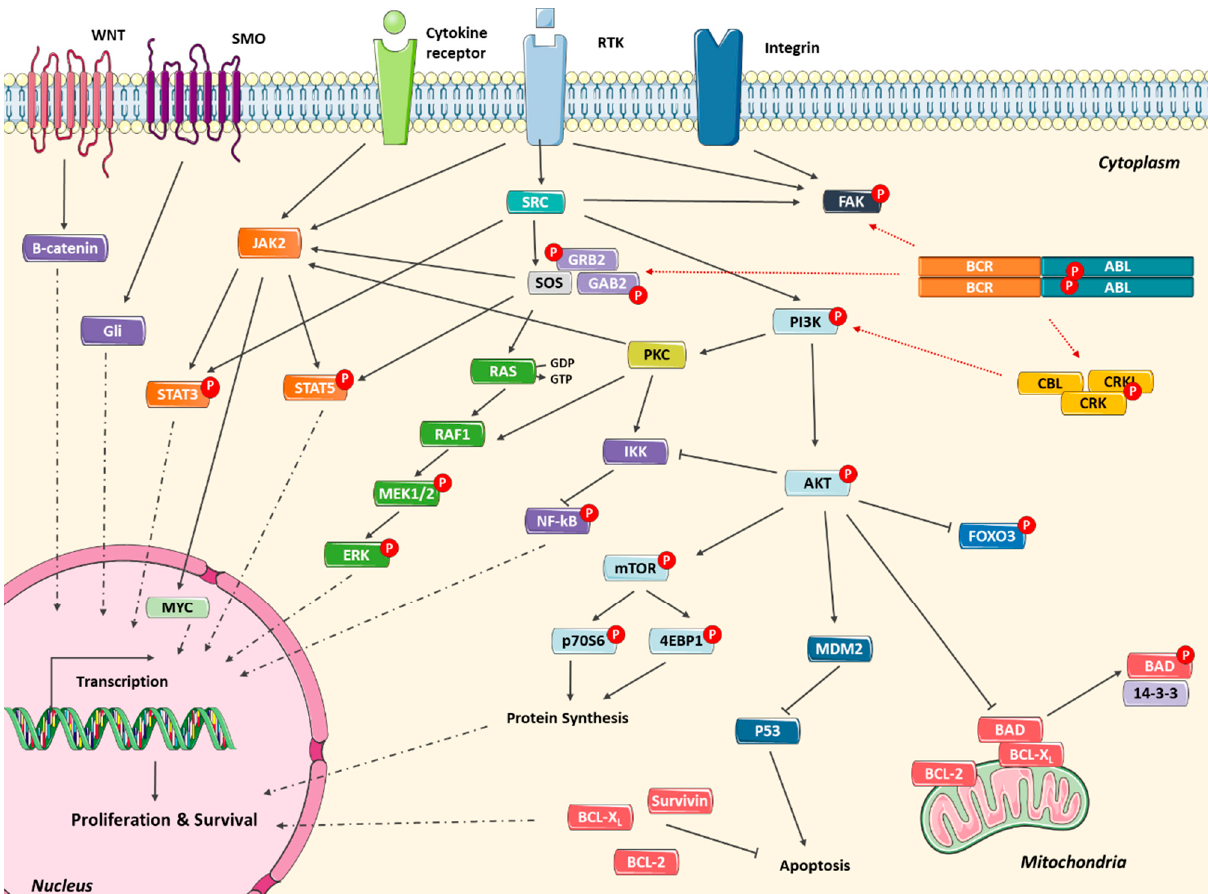
Figure 2. Alternative to BCR-ABL1 signaling network. To evade BCR-ABL1 inhibition, CML cells activate alternative signaling pathways including RAS/MAPK, SRC, JAK/STAT, WNT/b-catenin, hedgehog, and PI3K/AKT. The transduction of oncogenic signals culminates with the activation of multiple downstream signaling pathways that enhance survival, inhibit of apoptosis, and alter cell adhesion and migration. A subset of these pathways and their constituent transcription factors ( β -catenin, Gli, STAT5, MYC, FOXO3), serine/threonine-specific kinases (RAS/MAPKs, PI3K/AKT/mTOR), and apoptosis-related proteins (BAD, BCL-2, BCL-XL, survivin) are shown. It is important to note that this is a simplified diagram and that many more associations between BCR-ABL1 and signaling proteins have been reported.